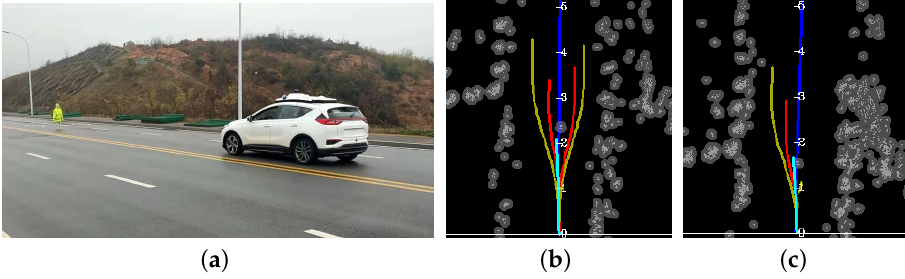
Figure 22. The driving envelope in real vehicle experiment. ( a ) The experimental scenario of collision avoidance with a dummy. ( b ) The obstacle map and the driving envelope at time t 1 . ( c ) The obstacle map and the driving envelope at time t 2 . [41]